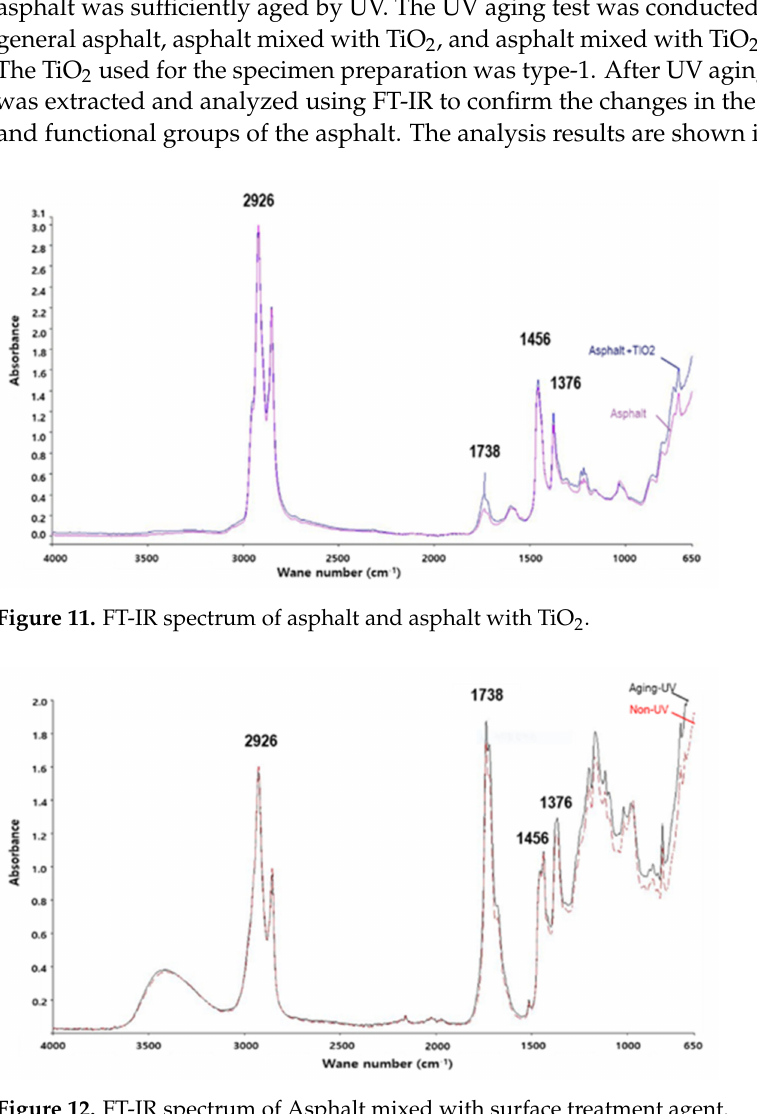
Figure 12. FT-IR spectrum of Asphalt mixed with surface treatment